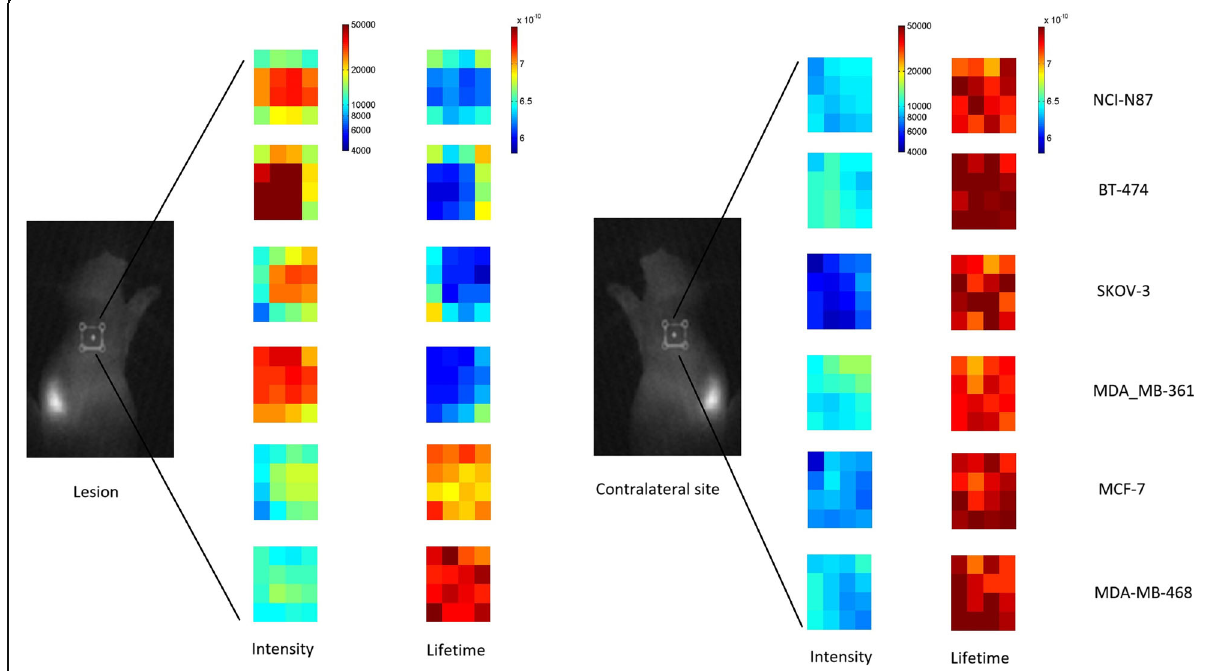
Fig. 1 Fluorescence intensity (a.u.) and lifetime (sec) measured at the tumor and contralateral sites, 1 h after injection of HER2-specific Affibody